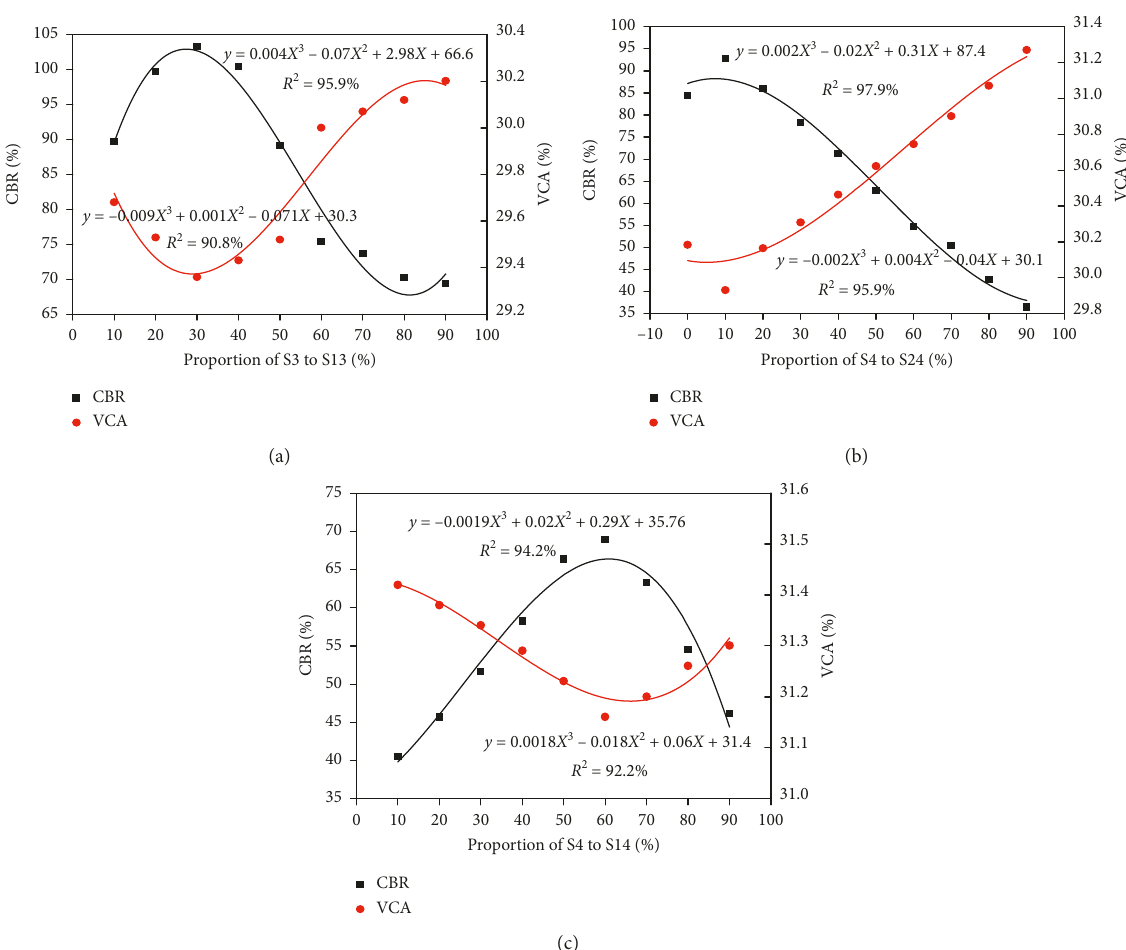
Figure 9: CBR and VCA of three kinds of two-aggregate mixtures with gap gradation (a) S13, (b) S24, and (c) S14.